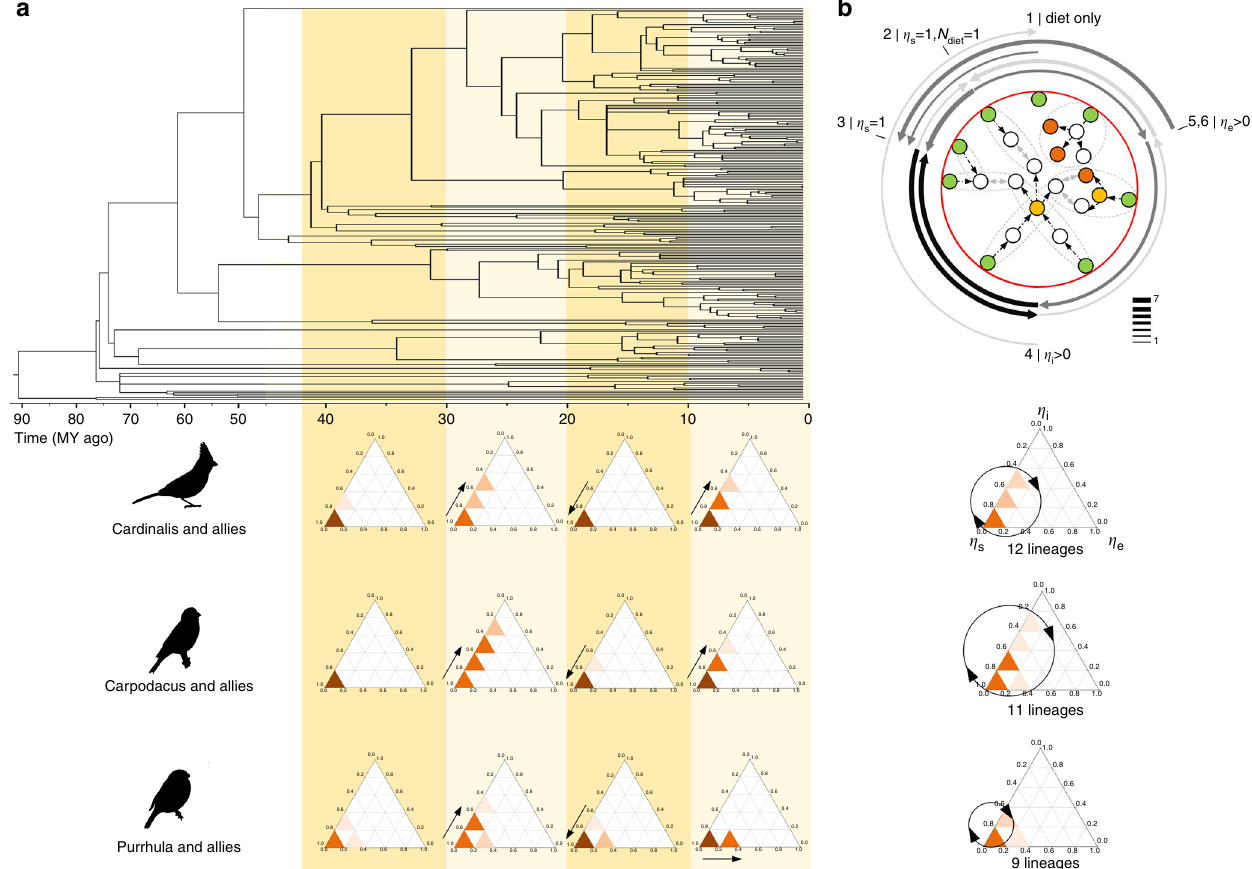
Fig. 6 Evolutionary cycles of control pro fi les. a Examples of control pro fi les in reconstructed networks in three avian groups, taking into account the shared ancestry of the lineages as delineated by phylogeny (Supplementary Fig. 4), binned by 10 my (shaded areas on phylogenetic tree) over the last 45 my. Control pro fi les of extant species of each group are shown on the right. In all lineages, gains of dietary carotenoids and associated increase in Ns has led to greater redundancy in source controls and, correspondingly lower η s and higher η i or η e in a subsequent period, followed by loss of some dietary carotenoids (Fig. 3, Supplementary Fig. 7) and repeat of the cycle. b The basis for the cycles in a is equally frequent transition between degenerative, source-dominated networks (category 3 in Fig. 1b) and networks with internal controls (category 4 in Fig. 1b). This transition was closely associated with the gain and loss of additional dietary carotenoids (Supplementary Fig. 7). Shown are the rates (line thickness) and likelihoods (shade) of evolutionary transitions between control categories. Black lines indicate highly likely transitions (zero-value rate parameters ( z ) in less than 1.5% of models), dark gray lines show likely transitions (1.5 < z ≤ 10% of models), and light gray shows probable transitions (10 < z < 20% of models), transitions with z > 20% are not shown. Supplementary Fig. 6 shows all results and Supplementary Fig. 1 lists sources for drawings. Cardinalis and allies include genera